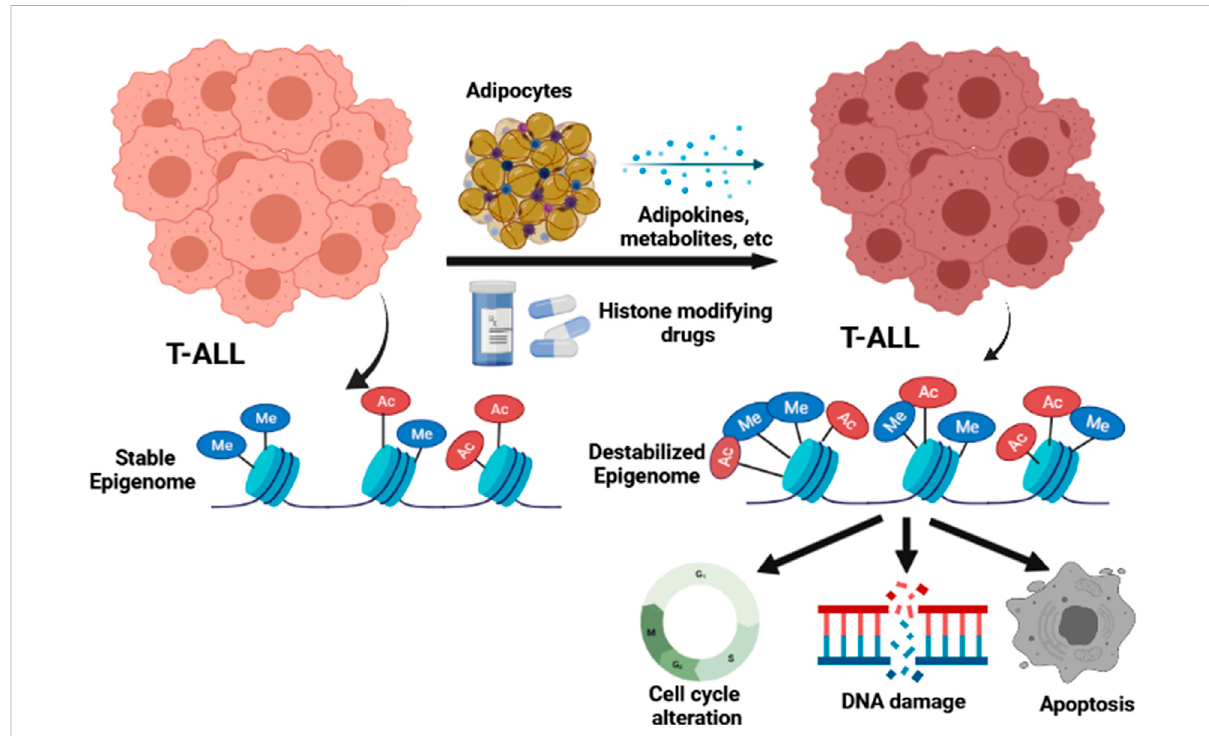
FIGURE 8 Model for how the adipocyte secretome and epigenetic modifying drugs impact the epigenome and function of human T-ALL cells.